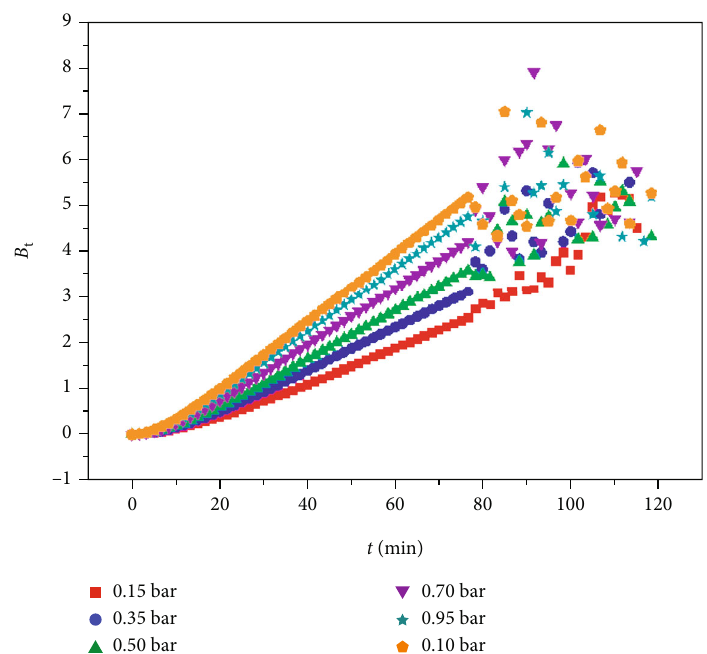
Figure 12: Plots of Boyd ’ s fi lm model for HF adsorption on 3A.